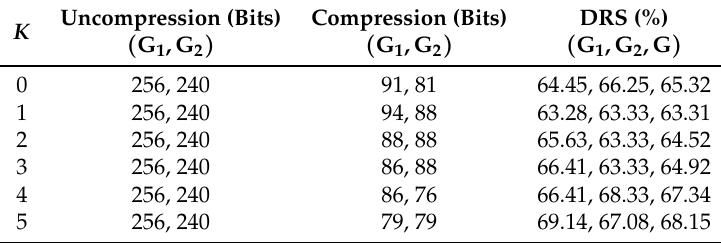
Table 4. Comparison results of varying K